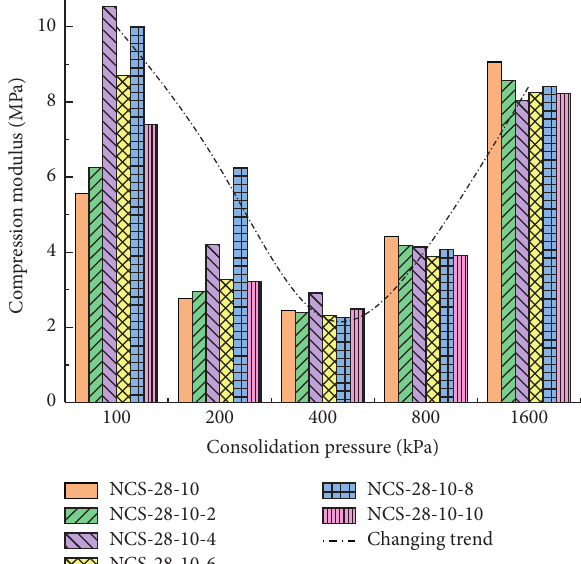
Figure 16: Es of NCS-28 with different consolidation pressure.